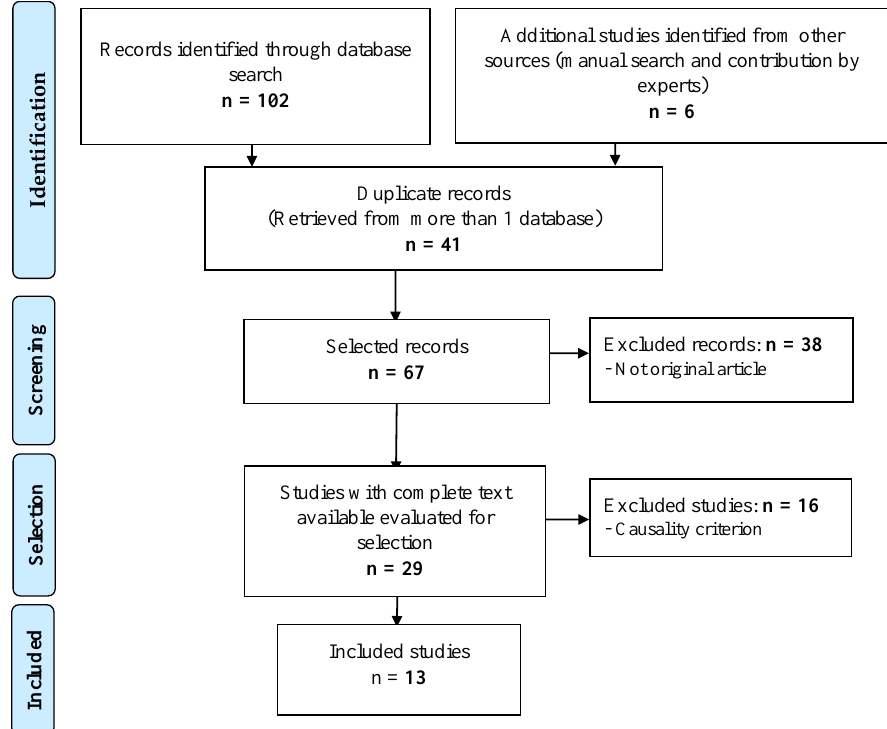
Figure 1. Selection procedure of the studies. All included studies examined the health economics of TDM in IBD patients treated with anti-TNF from 2013 to 2021. Moreover, 12 of them evaluated the TDM of infliximab and only one (ST1) evaluated the use of adalimumab. The summary of the characteristics of each study is listed in Table 1.